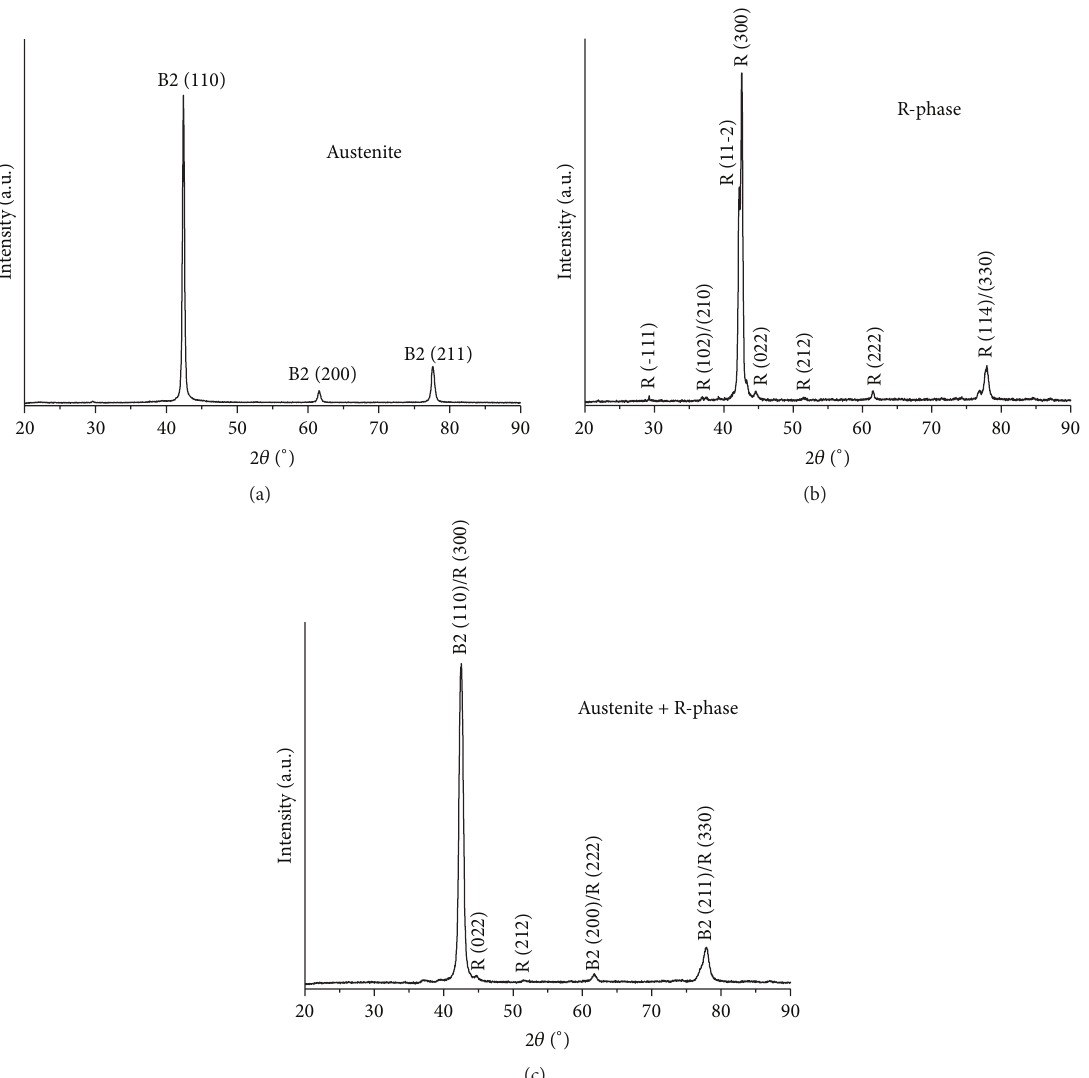
Figure 4: XRD patterns of the three wires used in this study: conventional superelastic (austenite), R-phase, and M-Wire (austenite + R-